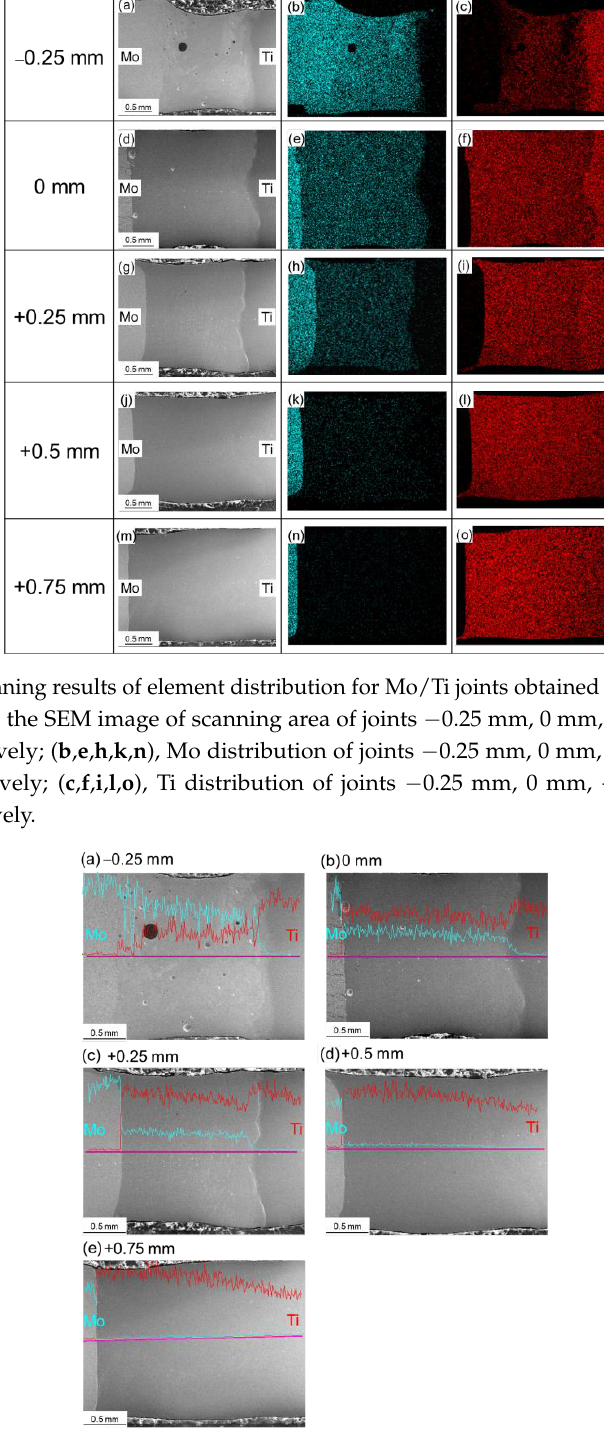
Figure 8. Line scanning results of element distribution for Mo/Ti joints obtained at various laser beam offsets. ( a ) the line scanning result of element distribution of joint −0.25 mm; ( b ) the line scanning result of element distribution of joint 0 mm; ( c ) the line scanning result of element distribution of joint +0.25 mm; ( d ) the line scanning result of element distribution of joint +0.5 mm; ( e ) the line scanning result of element distribution of joint +0.75